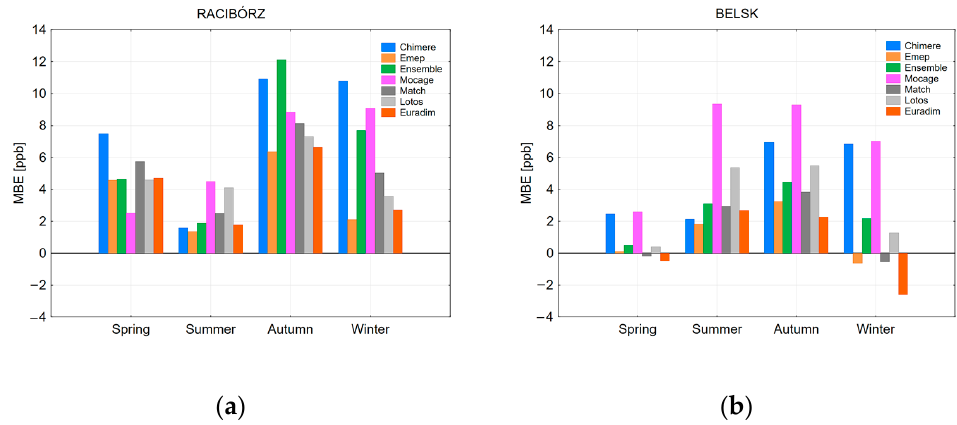
Figure 7. Mean bias error (see Equation (2) for definition), CAMS forecasts minus observed surface O 3 , for the period 2018–2021, separately for each season for Racib ó rz ( a ) and Belsk ( b ) station.